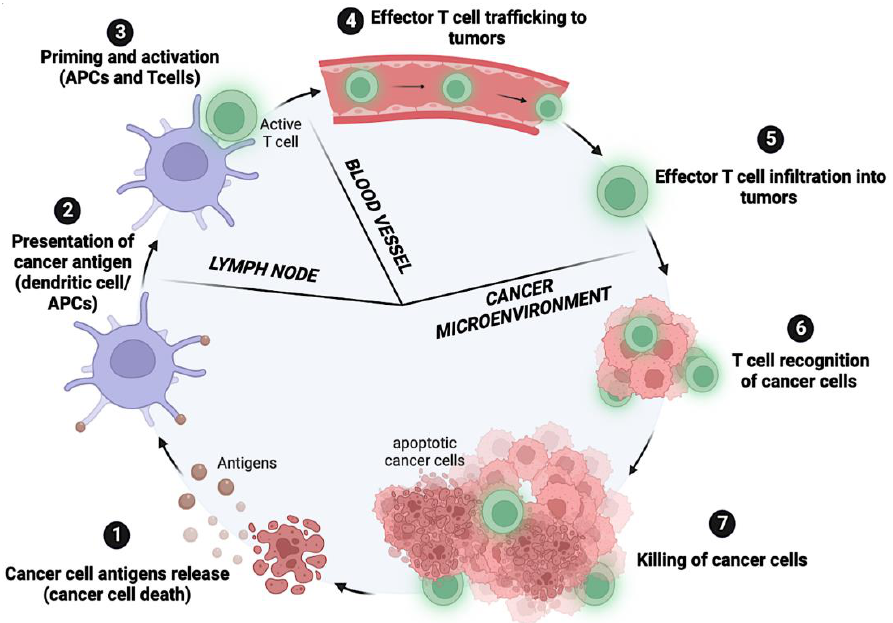
Figure 1. Schematic illustration of the cancer – immunity cycle, representing the seven key steps in developing an immune response against cancer: (1) Tumor antigens are released; (2) dendritic cells capture and present tumor antigens to T cells; (3) T cells are activated and differentiated to effector T cells; (4) effector T cells are trafficked to tumor cells; (5) effector T cells infiltrate the tumor tissue; (6) T cells recognize cancer cells; (7) cancer cell suppression. Adapted from [26]. Created with